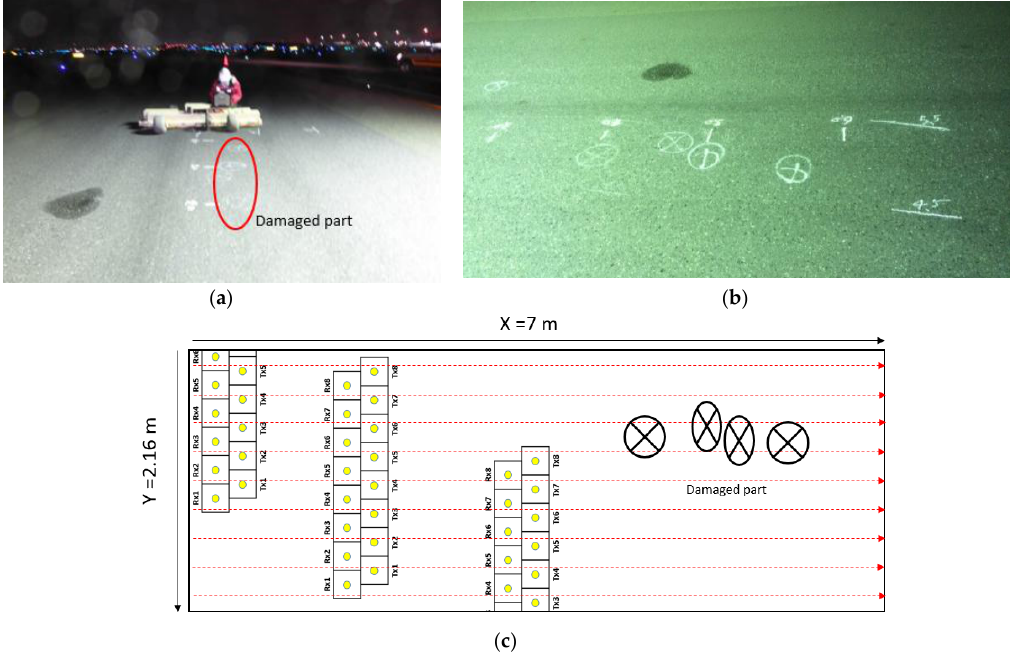
Figure 10. Data acquisition with Yakumo at Haneda international Airport. ( a ) Experiment site. ( b ) enlarged ground surface of damaged part; ( c ) sketch of processed area, each dash line indicates a CMP center.